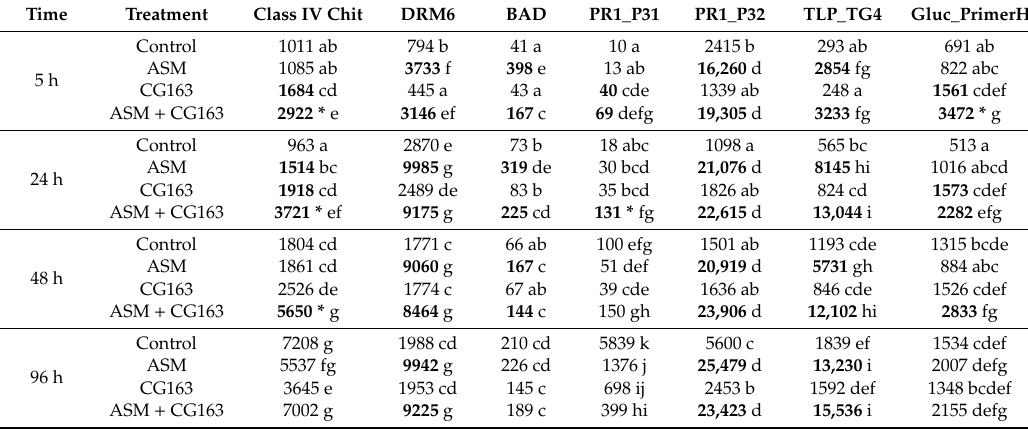
Table 1. Expression of Class IV chitinase (ClassIV_Chit), downy mildew resistant 6 (DRM6), benzyl alcohol dehydrogenase (BAD), pathogenesis-related protein 1 (PR1_P31), pathogenesis-related protein 1 (PR1_P32), thaumatin-like protein (TLP_TG4) and glucan endo 1,3- β -glucosidase (Gluc_PrimerH) genes in Actinidia chinensis var. deliciosa ‘Hayward’ kiwifruit treated with a single foliar spray of acibenzolar-S-methyl (ASM), Aureobasidium pullulans isolate CG163 (CG163), combination of ASM and CG163 (ASM + CG163) or untreated (control). This was followed by spray inoculation with 2 × 10 7 CFU / mL Pseudomonas syringae pv. actinidiae 7 days after treatment, and sampling of leaf tissue 5, 24, 48 and 96 h after inoculation. Gene expression was measured by CodeSet ® Nanostring and was normalised against expression of seven reference genes (see Supplementary Table S1 for details). Values are means of three independent biological replicates and are based on fitted mean back-transformed data. Gene-expression between di ff erent treatments and time points are compared within each separate column / gene. Treatments with di ff erent letters are significantly di ff erent according to Fisher’s Least Significant Di ff erence test (LSD) at the 5% level. Significant increases in gene expression compared with those in the untreated control are highlighted in bold. Asterisks indicate statistically significant di ff erences in gene expression between ASM + CG163 treatments and a single treatment of either ASM or